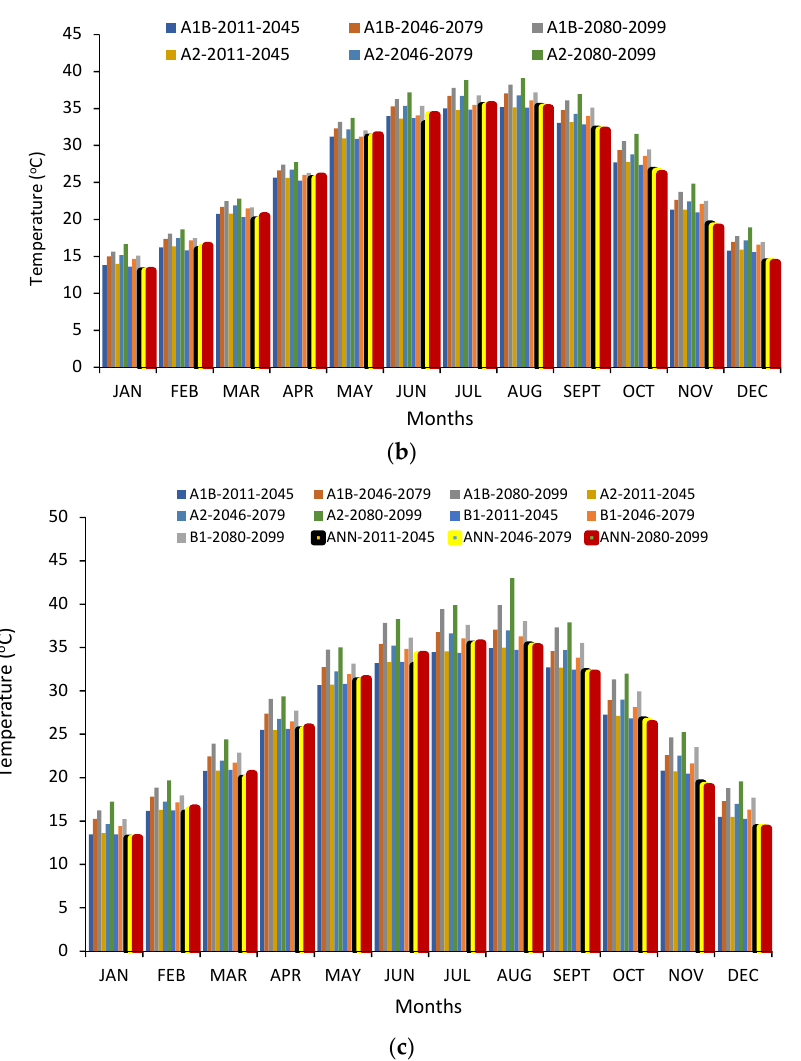
Figure 10. Temperature predicted by the ANN and various GCMs under three emissions scenarios: ( a ) temperature predicted by the ANN and GCM-HADCM3; ( b ) temperature predicted by the ANN and GCM-INCM3; and ( c ) temperature predicted by the ANN and GCM-MPEH5.